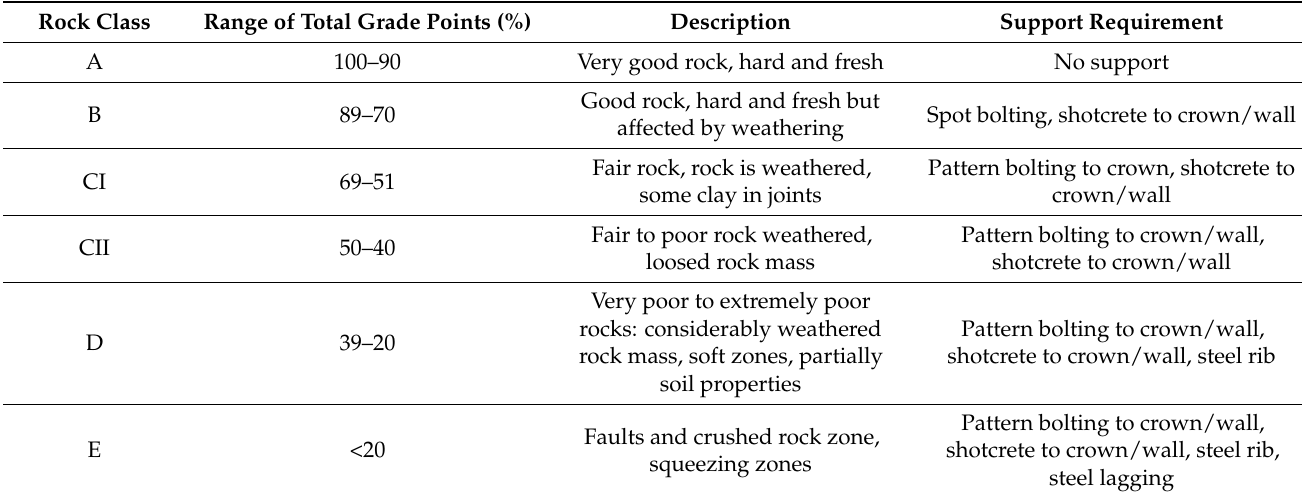
Table 2. Rock Mass Classes and Support Requirement of JH System (modified after Shinji et al. [24]). Rock Class